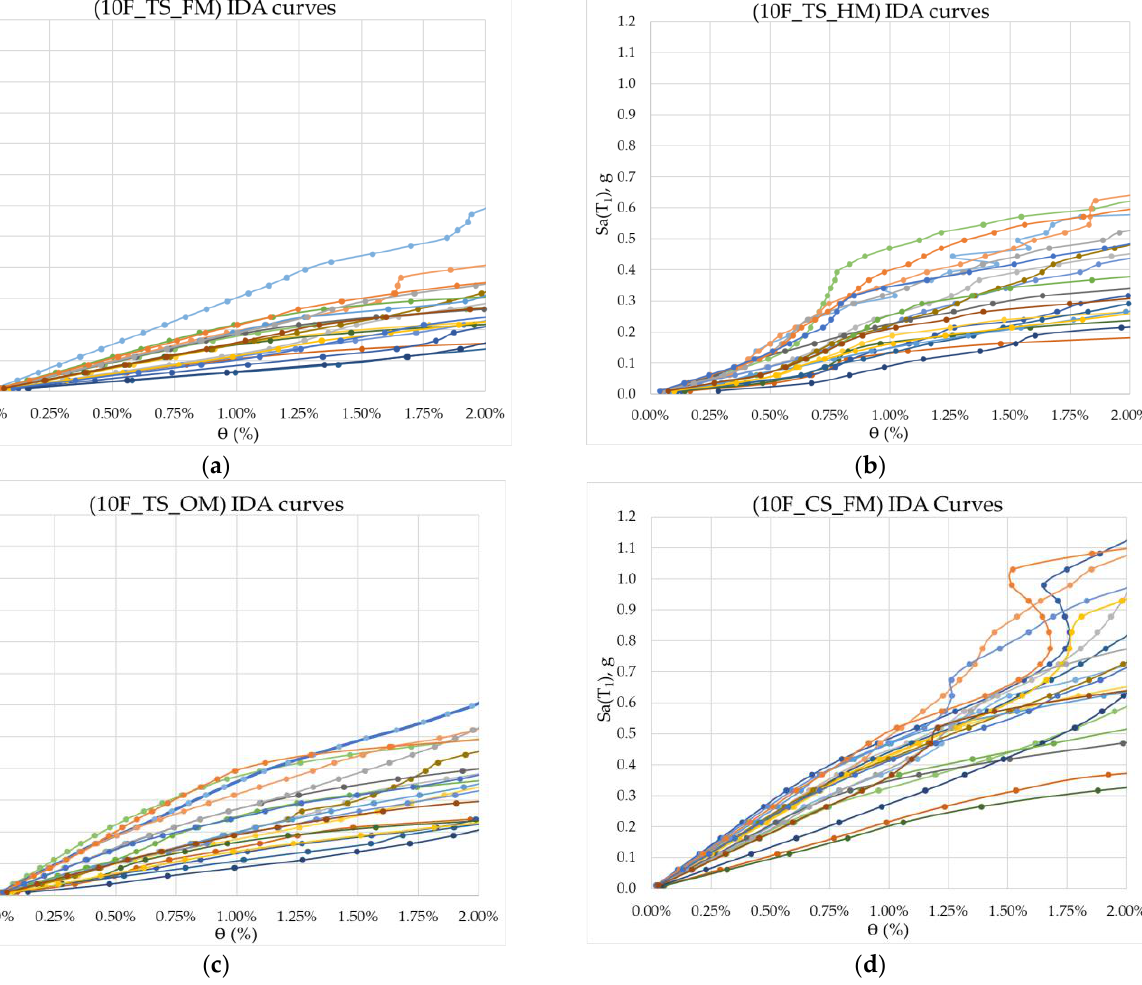
Figure 5. IDA curves for models: ( a ) 10F_TS_FM, ( b ) 10F_TS_HM, ( c ) 10F_TS_OM, ( d )